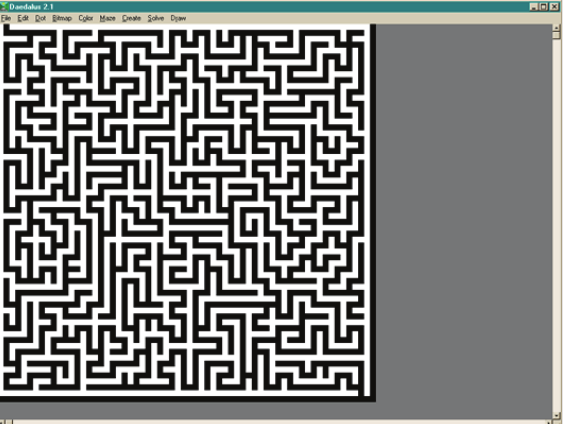
Figure 4: Two-dimensional maze generated by Daedalus program [13].